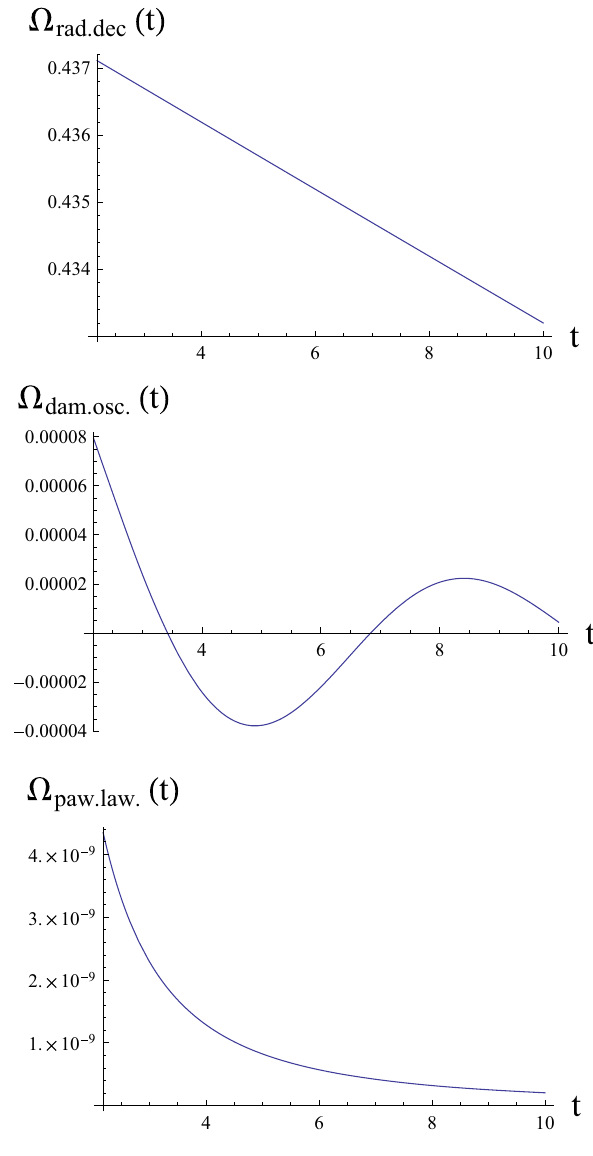
Fig. 5 The dependence Ω rad.dec. , Ω dam.osc. , Ω pow.law with respect to the cosmological time t for the best fit value of model parameter (see Table 1). The cosmological time t is expressed in s × Mpc